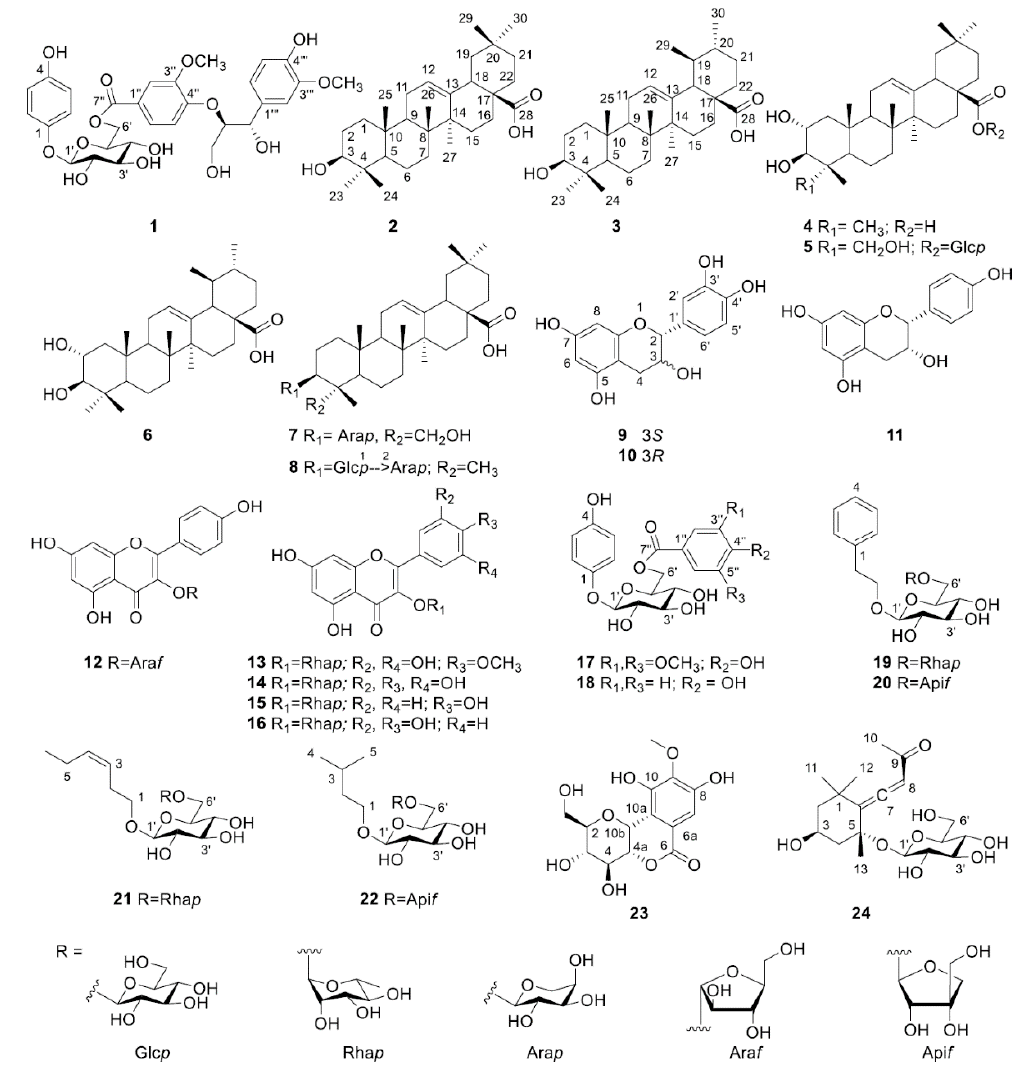
Figure 1. The chemical structures of compounds 1 – 24 from the aerial parts of Leea asiatica.